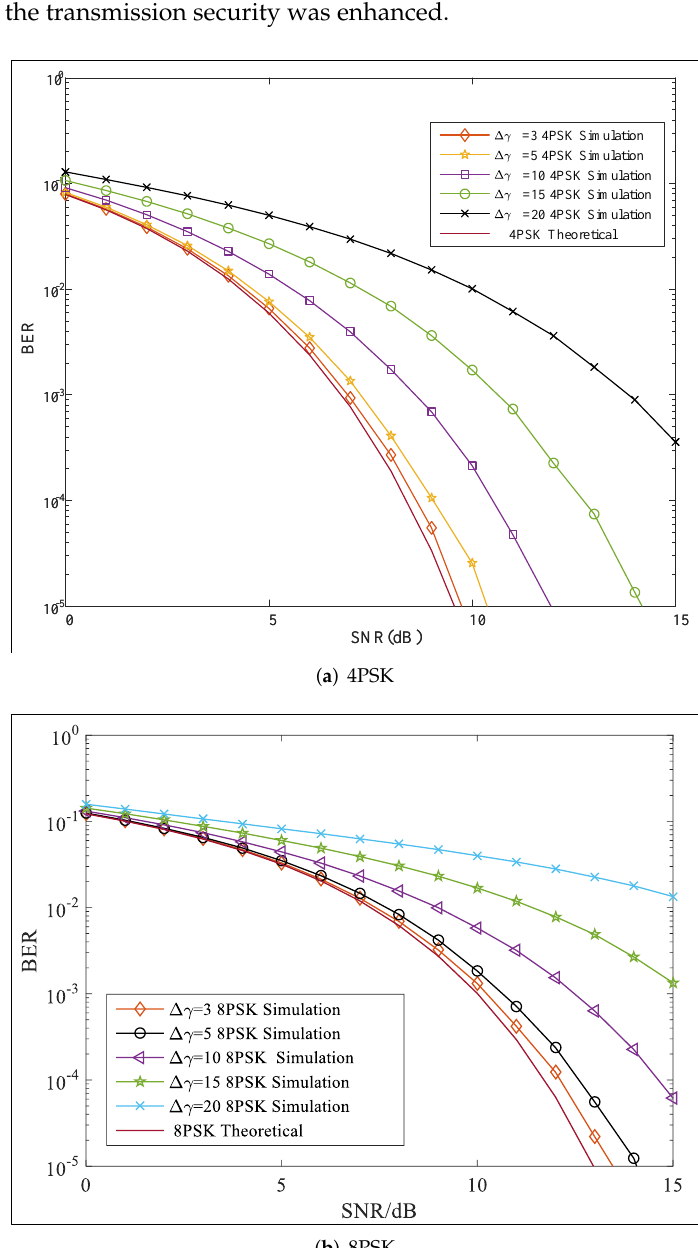
Figure 8. BER performance with PS errors ( ∆ γ